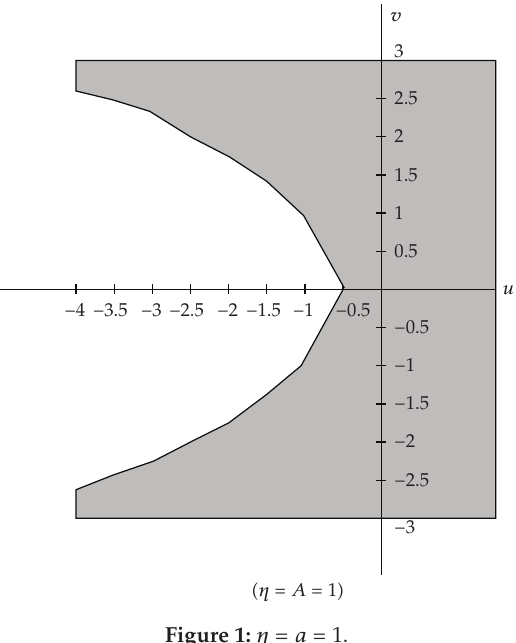
Figure 1: η (cid:4) a (cid:4) 1